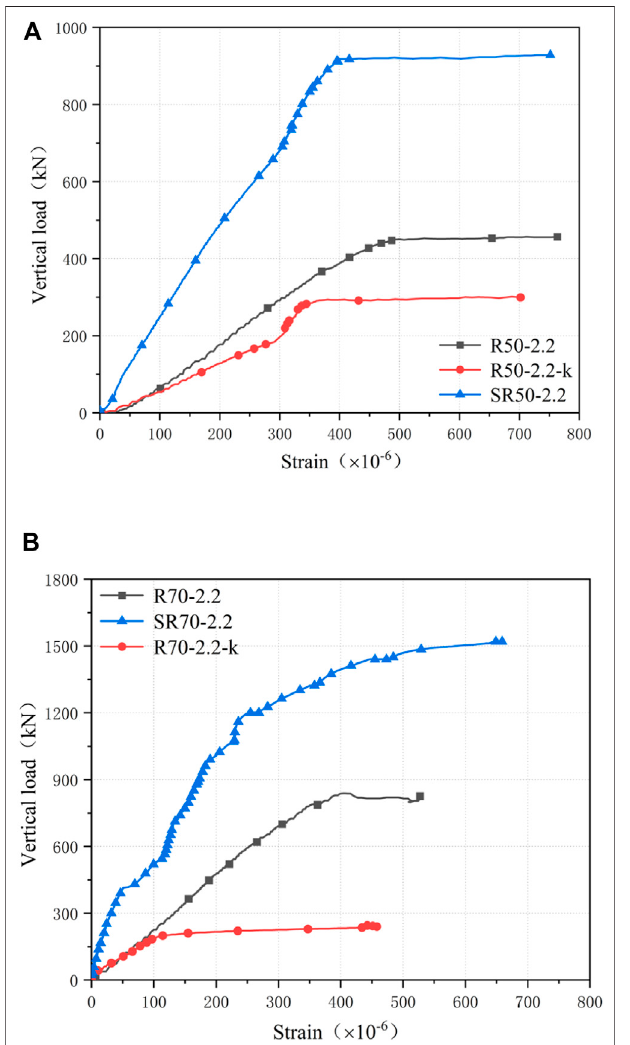
FIGURE 7 | (A) Load-strain curves of R50-2.2 series. (B) Load-strain curves of R70-2.2 series.